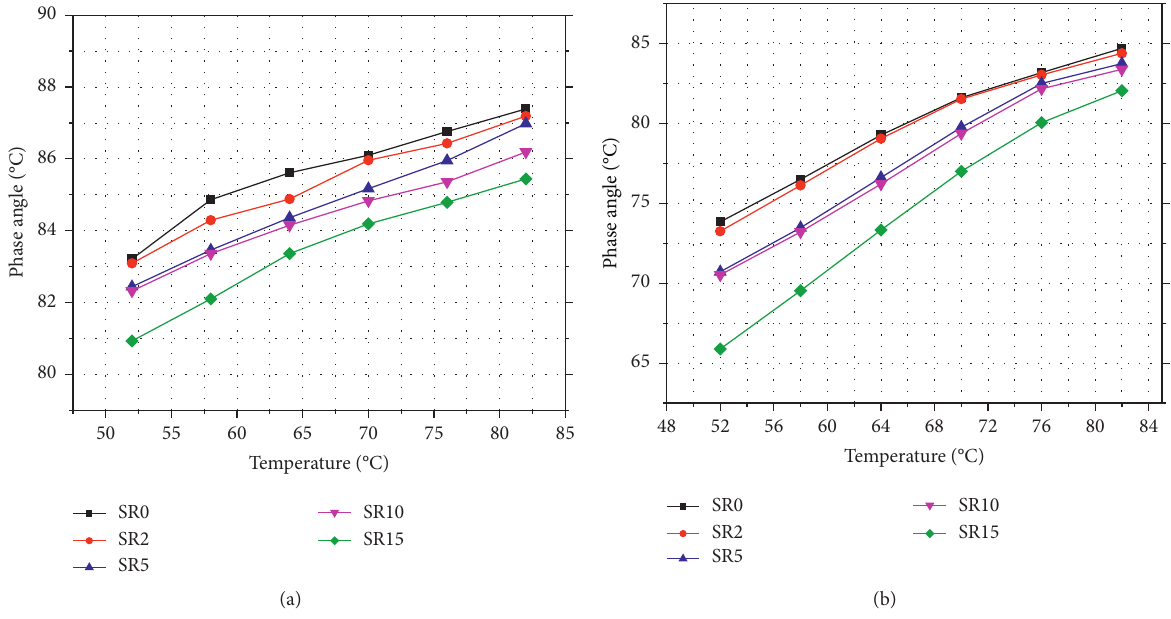
Figure 8: Phase angle of different asphalt binder type: (a) the unaged; (b) the RTFO-aged.